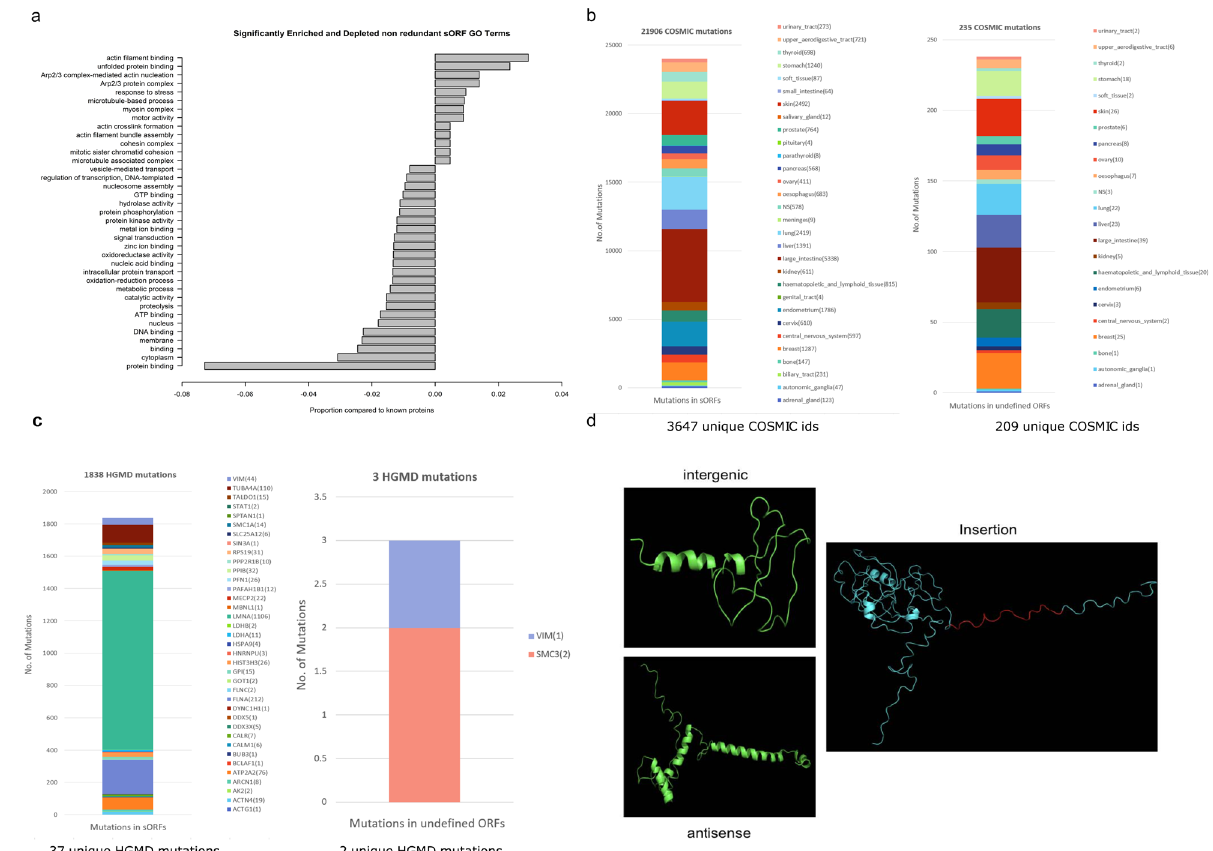
Fig. 5 Potential structures, biological functions and mutations mapped to nORFs translated in naive B and T cells. a List of signi fi cantly enriched or depleted GO terms in sORFs after removal of redundant sORFs as compared to GO terms from known proteins. b Results of mapping COSMIC mutations to sORFs (left) and unde fi ned ORFs (right) that are conserved in the human genome identi fi ed using tblastn and LiftOver. The total number of mutations identi fi ed are represented above the bars and the number of unique mutations is mentioned below the graph. c Results of mapping HGMD mutations to sORFs and unde fi ned ORFs that are conserved in the human genome identi fi ed using tblastn and LiftOver. The total number of mutations identi fi ed are represented above the bars and the number of unique mutations is mentioned below the graph. Disease phenotypes and the number of mapped mutations associated with the genes in the legend are expanded in Supplementary Table 2. d (left) Predicted structure of intergenic mouse nORF in chr 14, (right) the predicted structure of the original Rps3a1 protein (cyan) with intron insertion fragment (red), (bottom) predicted structure of antisense mouse nORF, antisense to Raet1